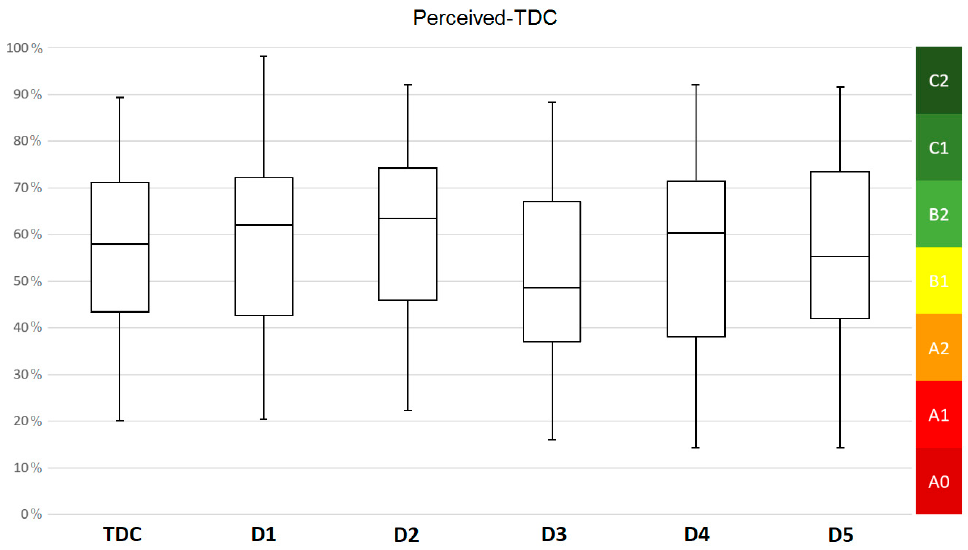
Figure 1. Box diagram showing the frequency distribution, expressed in percentages, of teacher perceived Teaching Digital Competence (TDC) scores and scores in the 5 dimensions of TDC: D1, D2, D3, D4, and D5. The horizontal line within each box marks the median. The lower and upper limits of each box correspond to the 25th and 75th percentiles, respectively. The upper and lower ends of the vertical lines refer to the outliers.